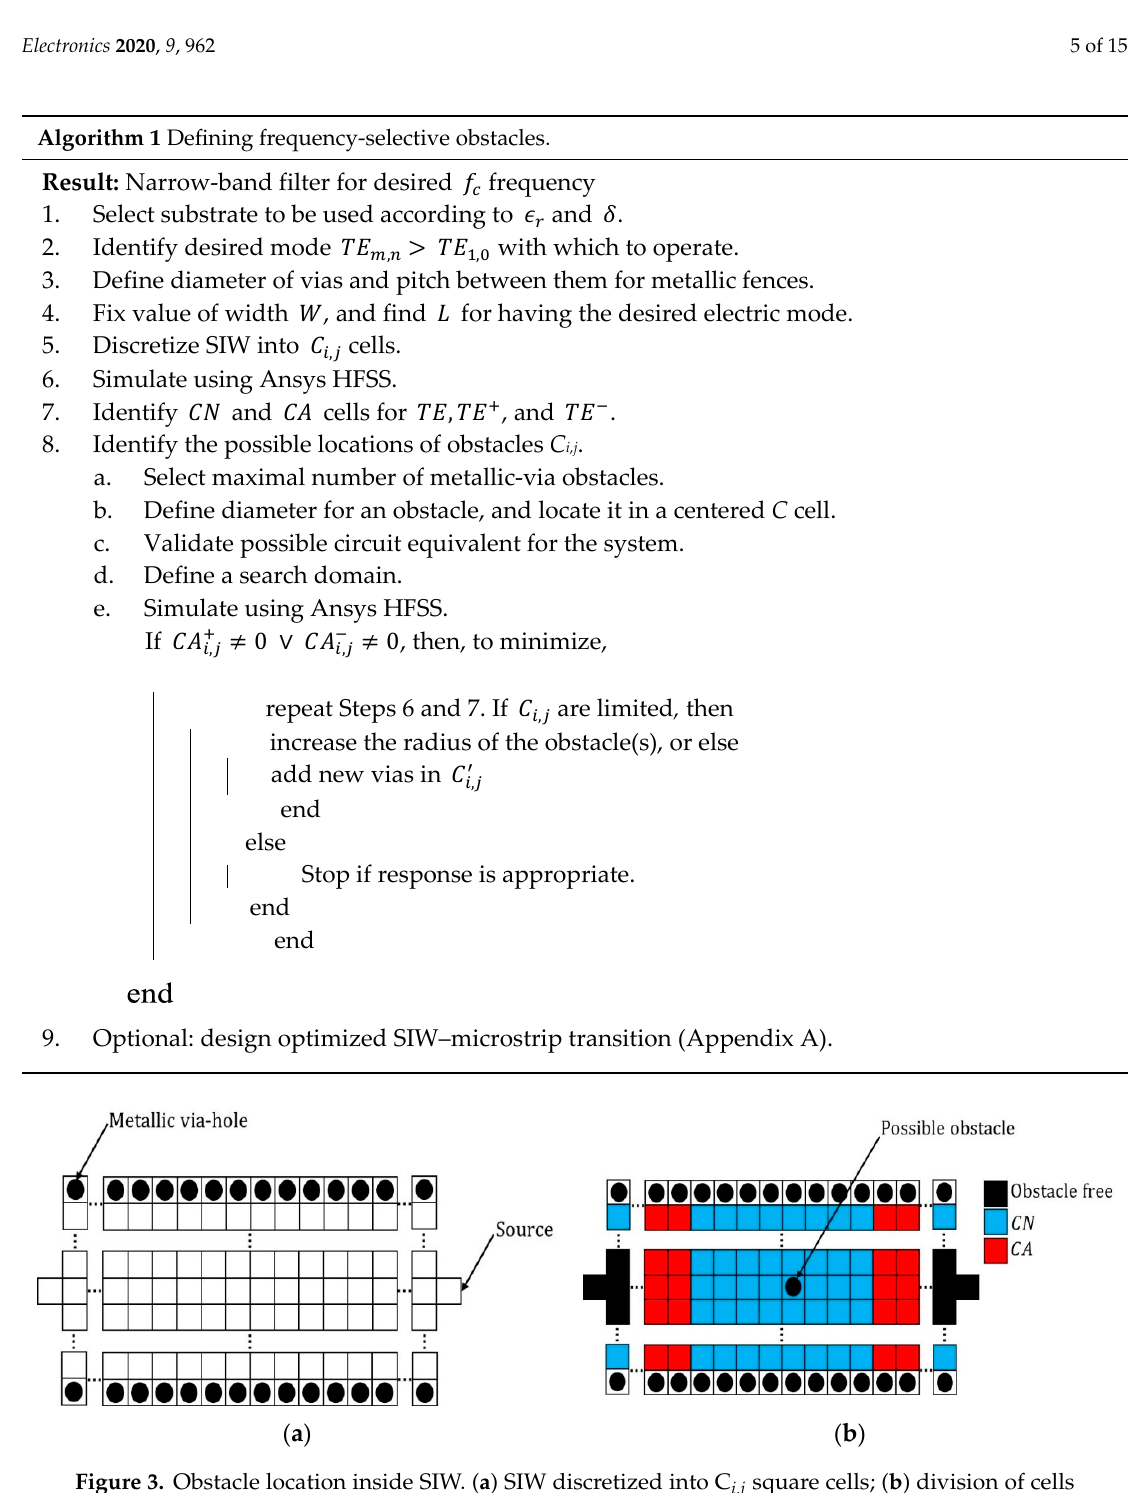
Figure 3. Obstacle location inside SIW. ( a ) SIW discretized into C i,j square cells; ( b ) division of cells inside SIW. Algorithm 1 Defining frequency-selective obstacles